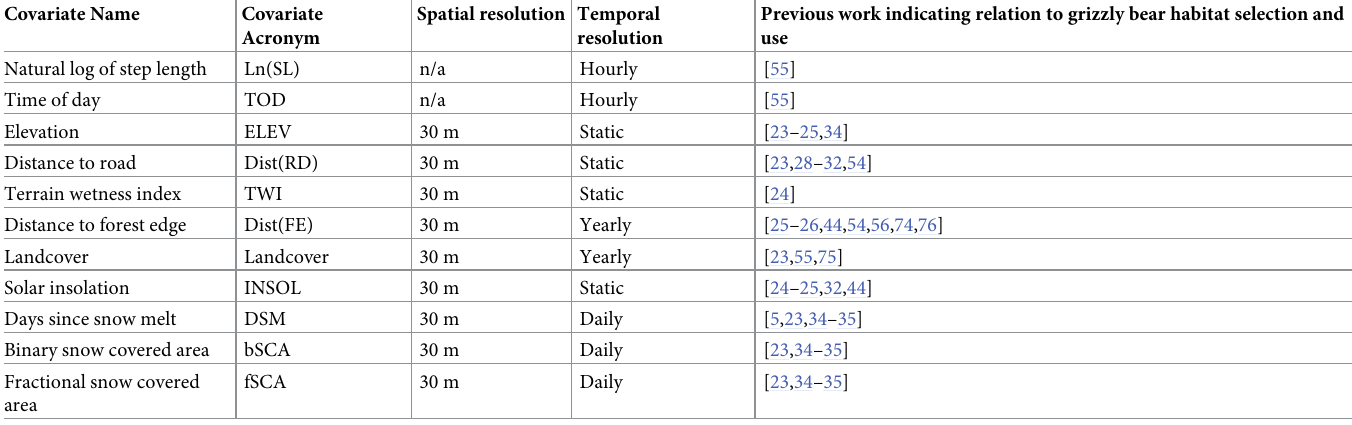
Table 1. Covariates used in models and references to studies linking variables to grizzly bear habitat selection and use. Covariate Name Covariate Spatial resolution Temporal Acronym